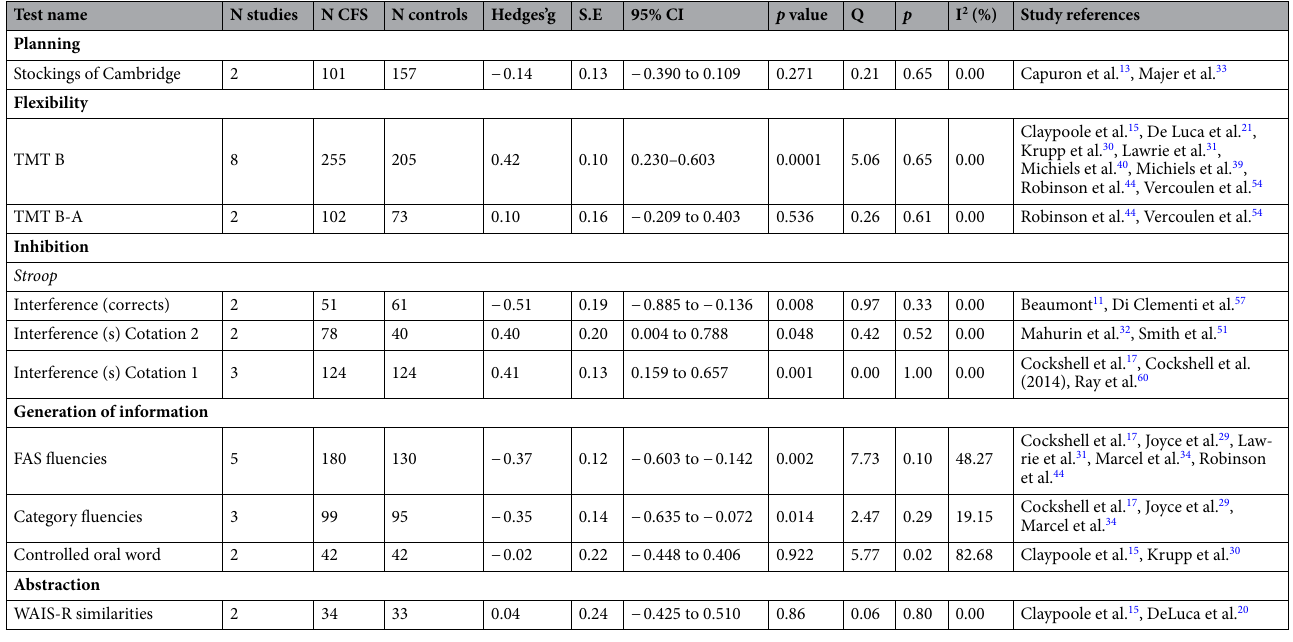
Table 9. Executive functions: Hedge’s g effect sizes for each test, in descending order. TMT trail making test, WAIS Wechsler adult intelligence scale, ME/CFS myalgic encephalomyelitis/chronic fatigue syndrome, N number.